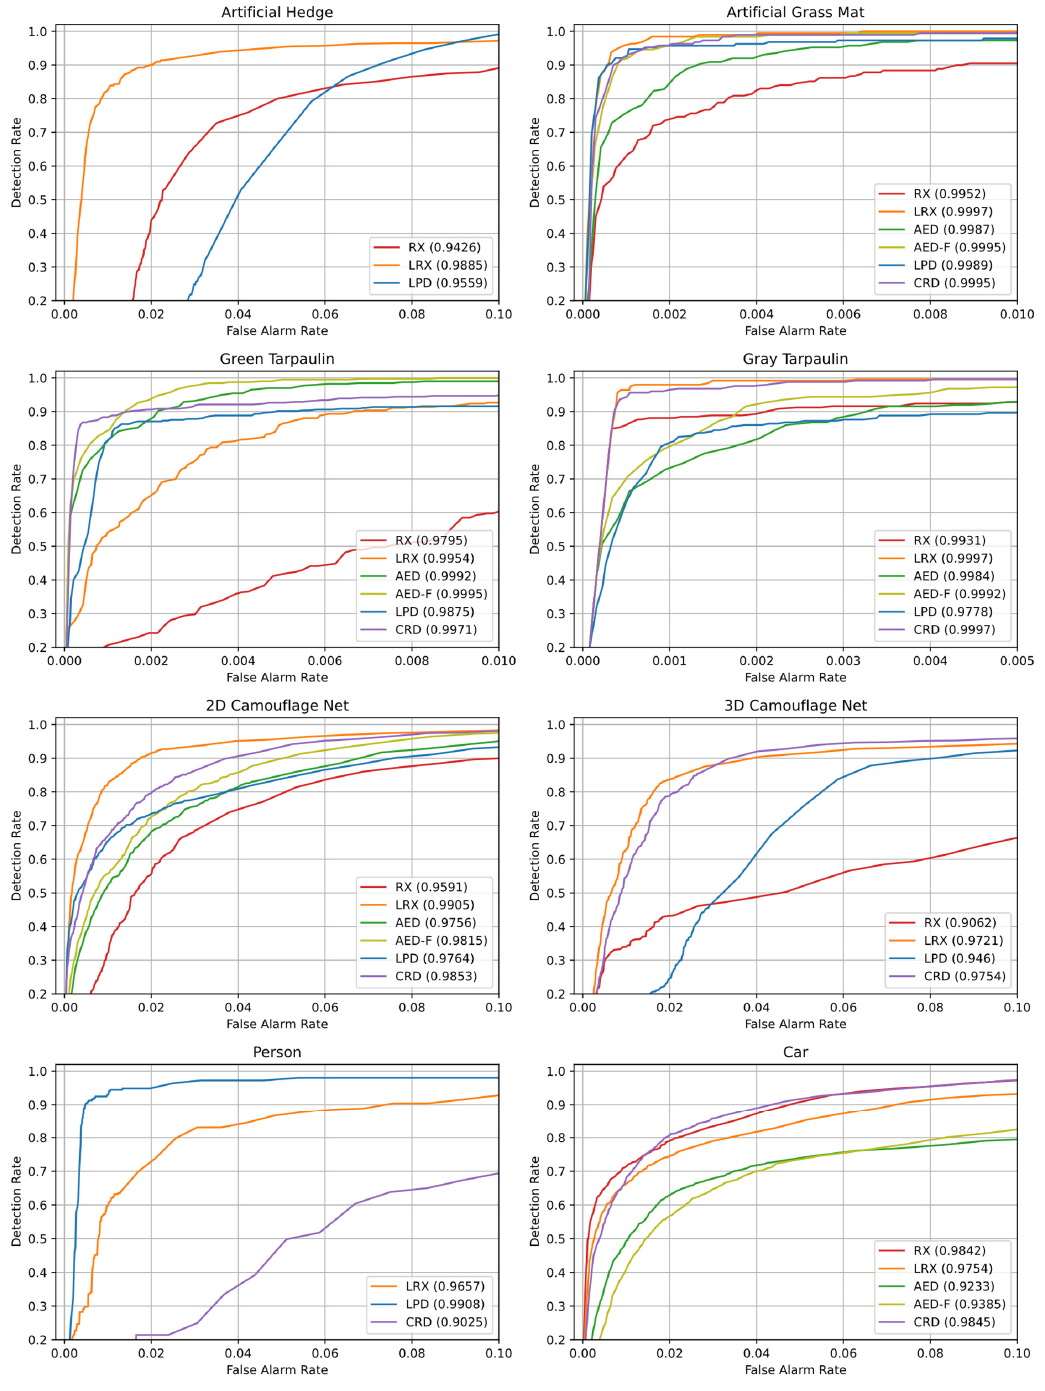
Figure 9. Receiver operating characteristics (ROCs) and areas under the curve (AUCs) for individual target classes of every method applied on MUCAD-VI. Algorithms that achieved an AUC less than 0.9 are not included. Note that each plot has individual limits for the